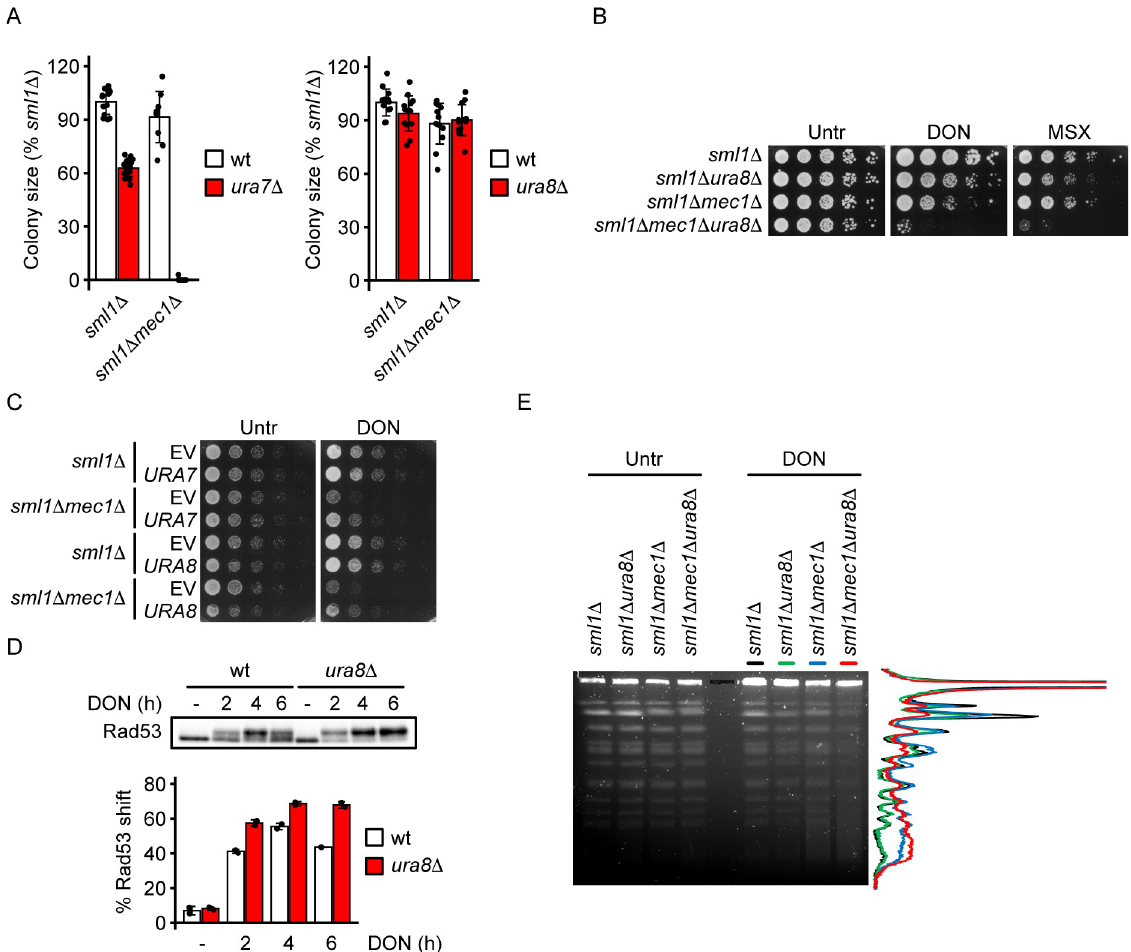
Fig 4. CTP synthase limits DDR activation by glutamine analogs. (A) Analysis of the genetic interaction of MEC1 with URA7 (left panel) and URA8 (right panel) by tetrad dissection. Tetrads were dissected into single spores, colony sizes were measured after 3 days at 28˚C and genotypes were determined by replica plating. (B) 10 7 cells / mL of the indicated genotype in the W303 background were serially diluted (1:6), spotted on YPD plates with 50 μ M DON or 15 μ M MSX as indicated and grown for 2d. (C) 10 7 cells / mL of the indicated genotype in the W303 background expressing URA7 or URA8 from a plasmid with a galactose-inducible promoter were serially diluted (1:6), spotted on YP + 2% galactose plates with or without 150 μ M DON and grown for 3d. (D) Cells of the indicated genotypes were arrested in G1 phase with α - factor, released into YPD with 300 μ M DON and fixed in TCA at the indicated time points. The electrophoretic mobility shift of the Rad53 protein reflecting its phosphorylation was analyzed by Western blot. The percentage of phosphorylated vs. total Rad53 was quantified using ImageJ software and represented in the bar plot (n = 2 independent replicate cultures). (E) Cells of the indicated genotypes were arrested in G1 phase with α -factor, released into YPD with or without 50 μ M DON for 6h and fixed with sodium azide. Chromosome integrity was analyzed by pulsed-field gel electrophoresis analysis and staining of DNA with ethidium bromide. The right panel shows the quantification of DNA signal along the gel lanes containing DON-treated samples. Bars plots with error bars represent mean values and standard deviation. Representative Western blot, DNA gel and spot assay images are shown. wt = wildtype, EV = empty vector, Untr = Untreated.